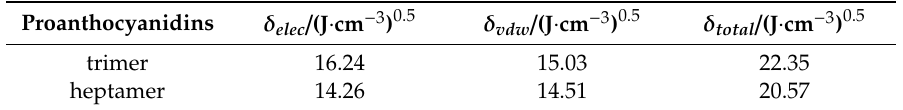
Table A7. Solubility parameters of proanthocyanidins simulated by molecular dynamics at 298.15K with di ff erent degrees of polymerization.